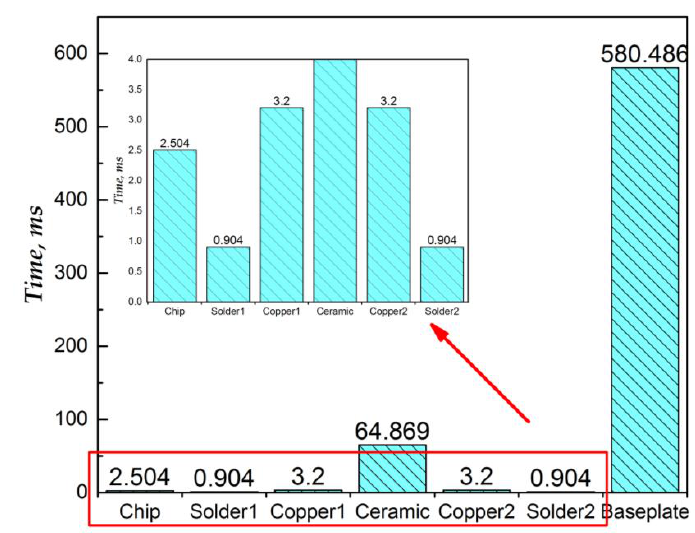
Figure 6. Time to reach steady-state of each layer.